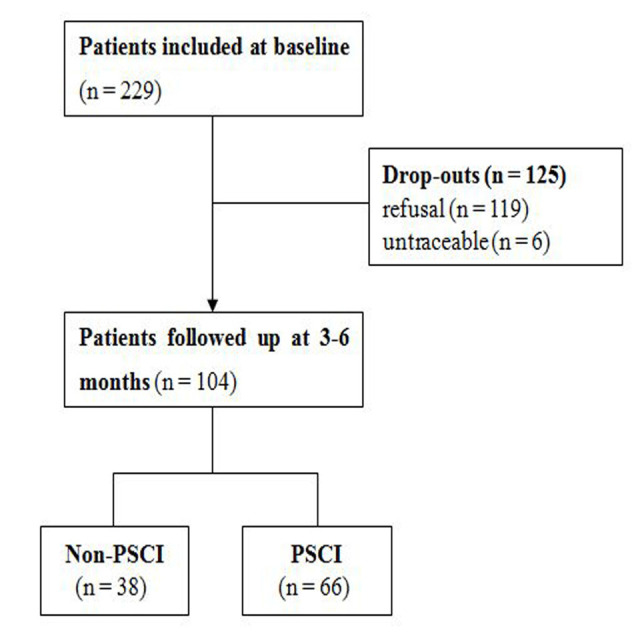
Flowchart depicting the study.